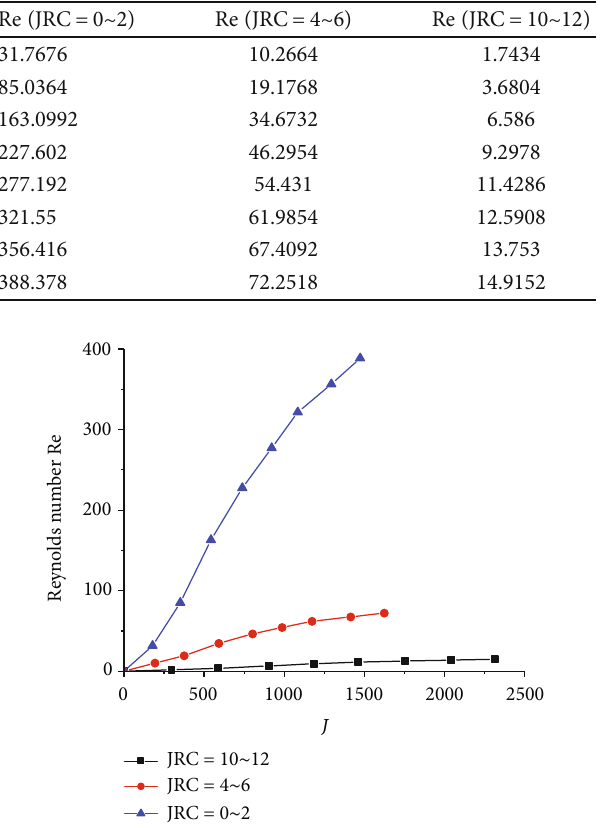
Figure 11: Temperature variation measured by the FBG